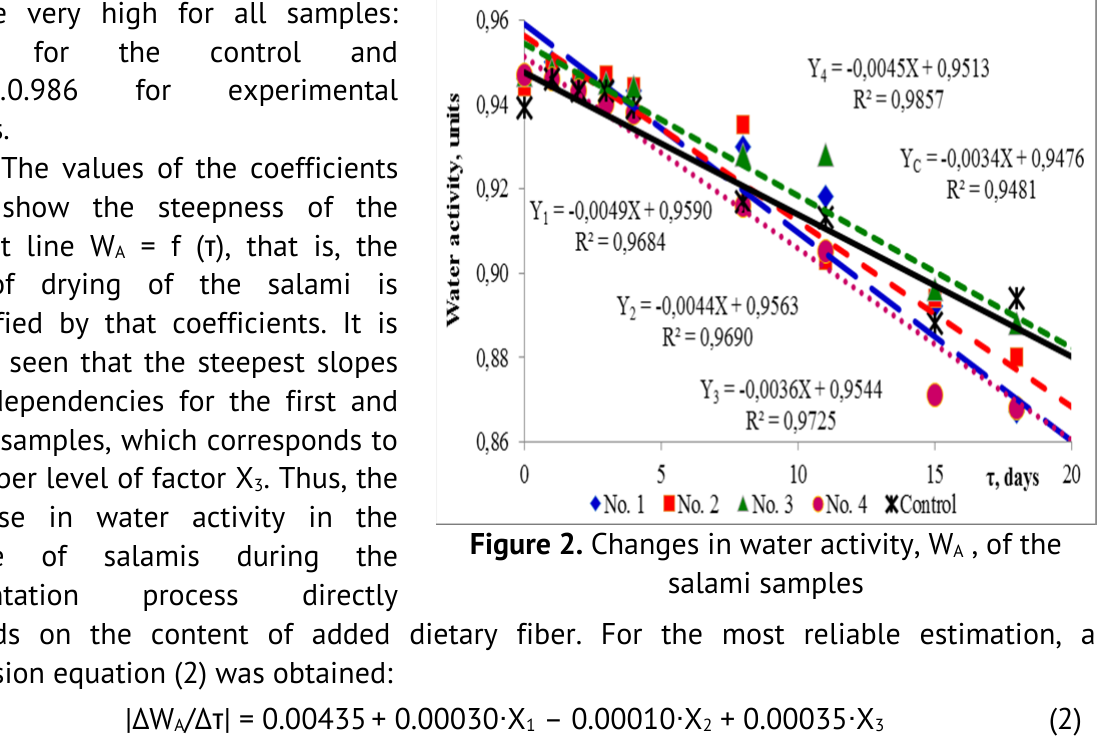
Figure 2. Changes in water activity, W